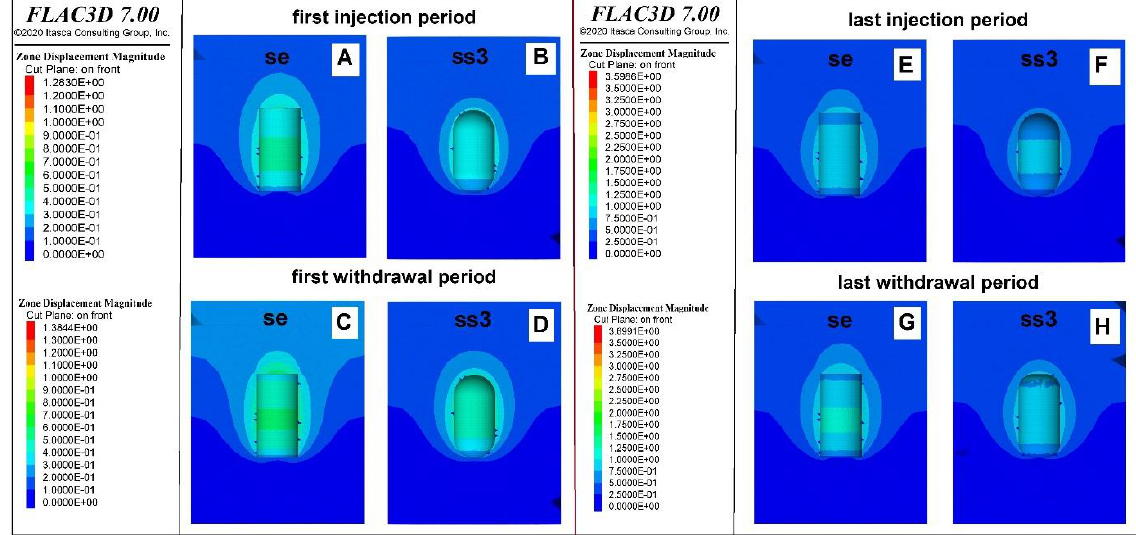
Figure 9. The displacements in the cylindrical caverns with se and ss3 for the first and last cycle ( A – H ).